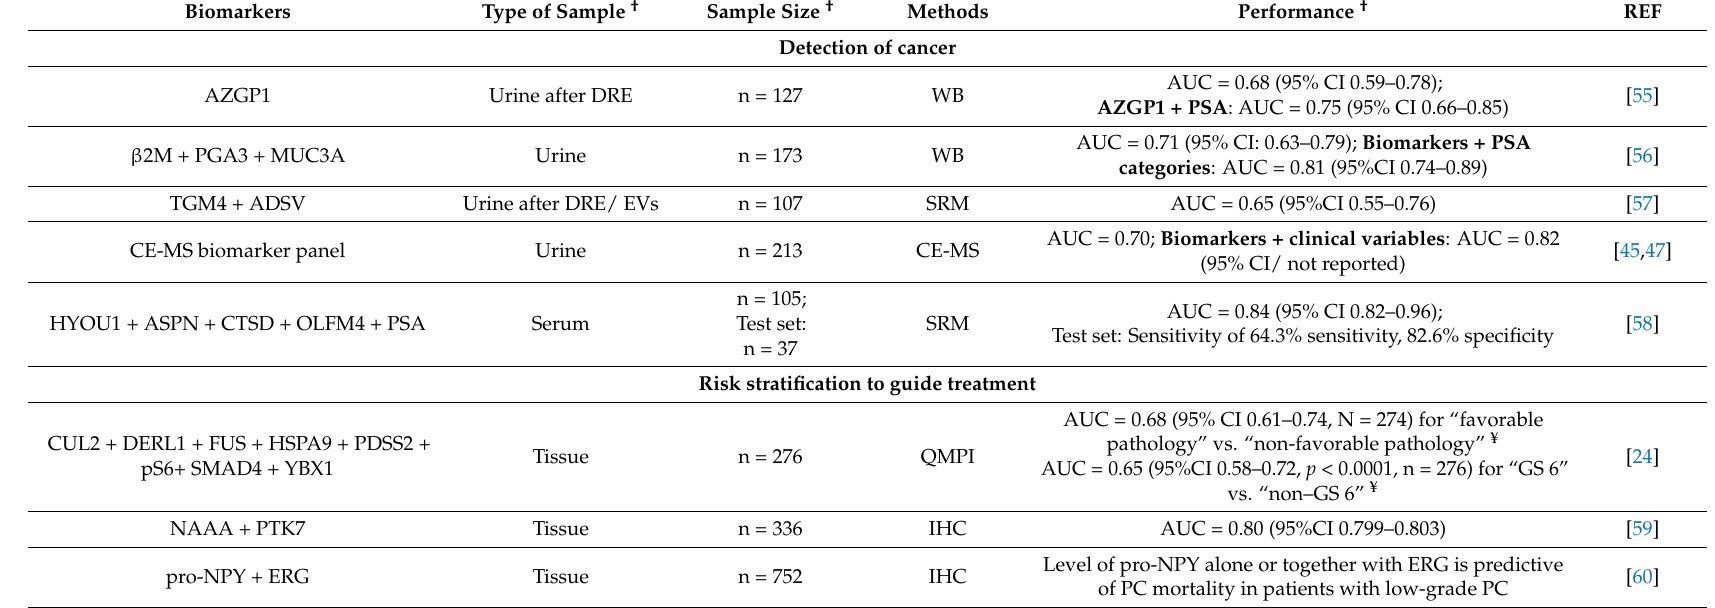
Table 3. Most promising proteomics-derived biomarkers for Prostate